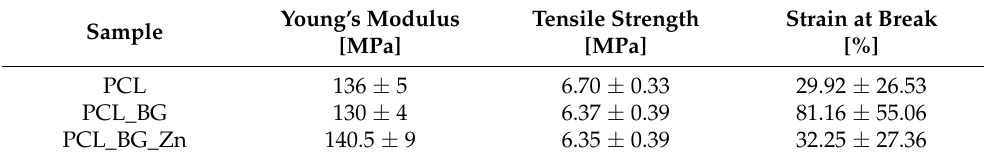
Table 4. Mechanical properties of scaffolds made of PCL stick filaments: PCL, PCL_BG, PCL_BG_Zn. Sample